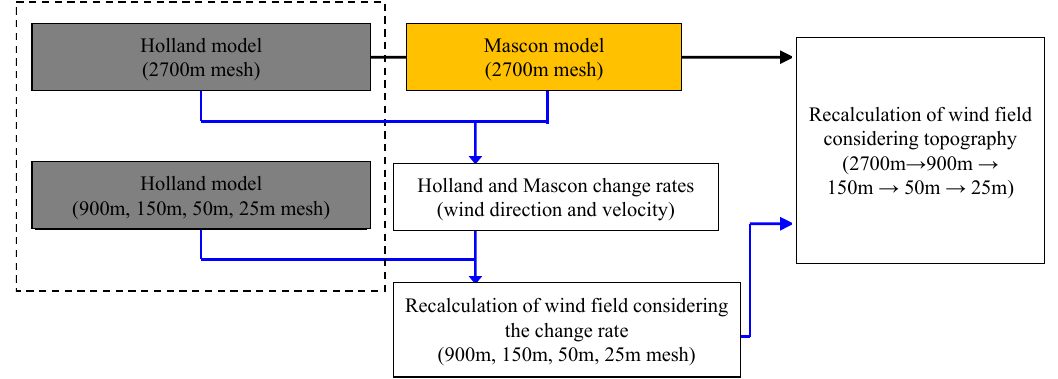
Figure 13. Wind field estimation flowchart considering topography.